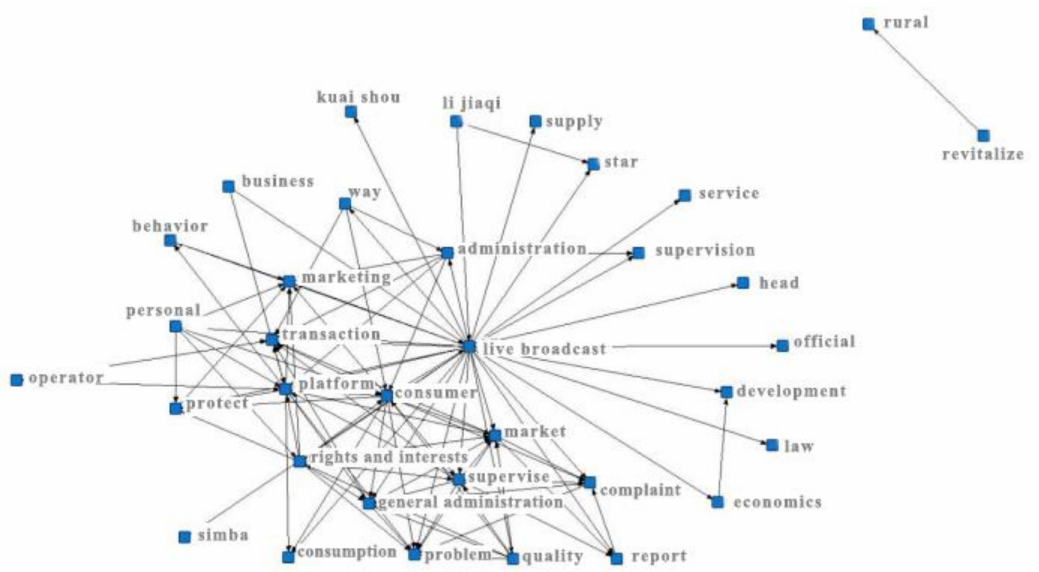
Figure 2. Co-occurrence matrix network diagram of